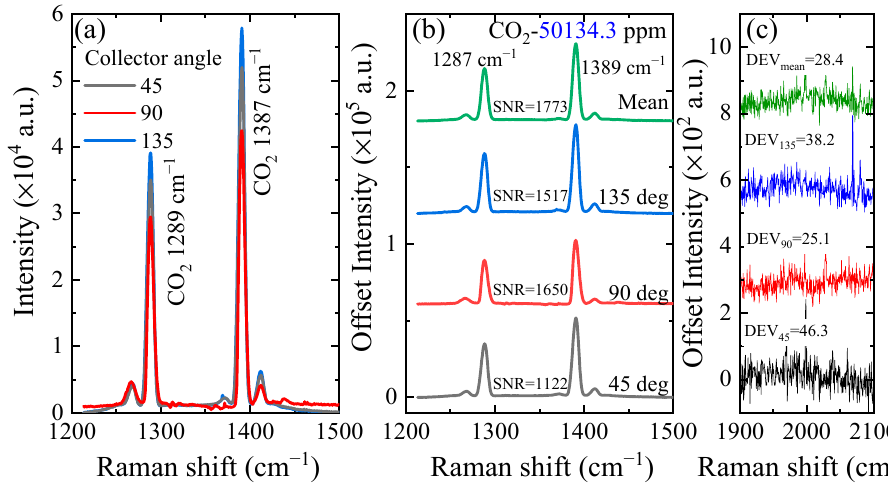
Figure 3. ( a ) The Raman spectra of CO 2 at different collection angles. ( b ) Comparison of the signal-to-noise ratios (SNRs) of the four spectra; the three at the bottom are the spectra at different collection angles and the one at the top (in green) is the mean value of these three spectra. ( c ) The noise intensity of the four spectra.